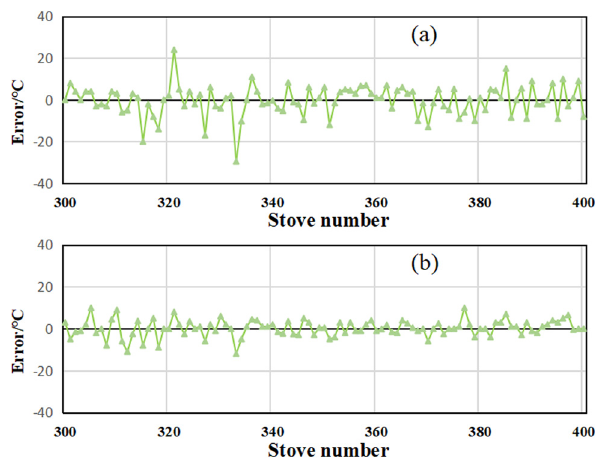
Figure 8: Errors in the prediction results of the two models. ( a ) AdaBoost model; ( b ) AdaBoost ensemble tree model based on K - means clustering algorithm.